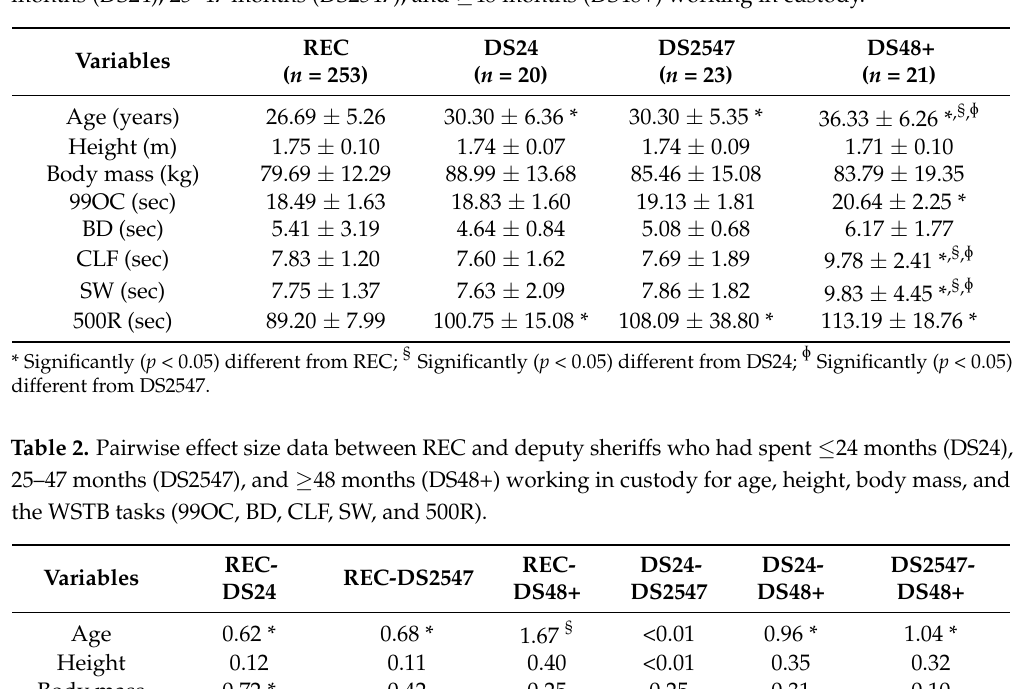
Table 1. Descriptive data (mean ± SD) for age, height, body mass, and the Work Sample Test Battery (WSTB) tasks [99-yard obstacle course (99OC), body drag (BD), chain link fence climb (CLF), solid wall climb (SW), and 500-yard run (500R)] in recruits (REC), and deputy sheriffs who had spent ≤ 24 months (DS24), 25–47 months (DS2547), and ≥ 48 months (DS48+) working in custody.